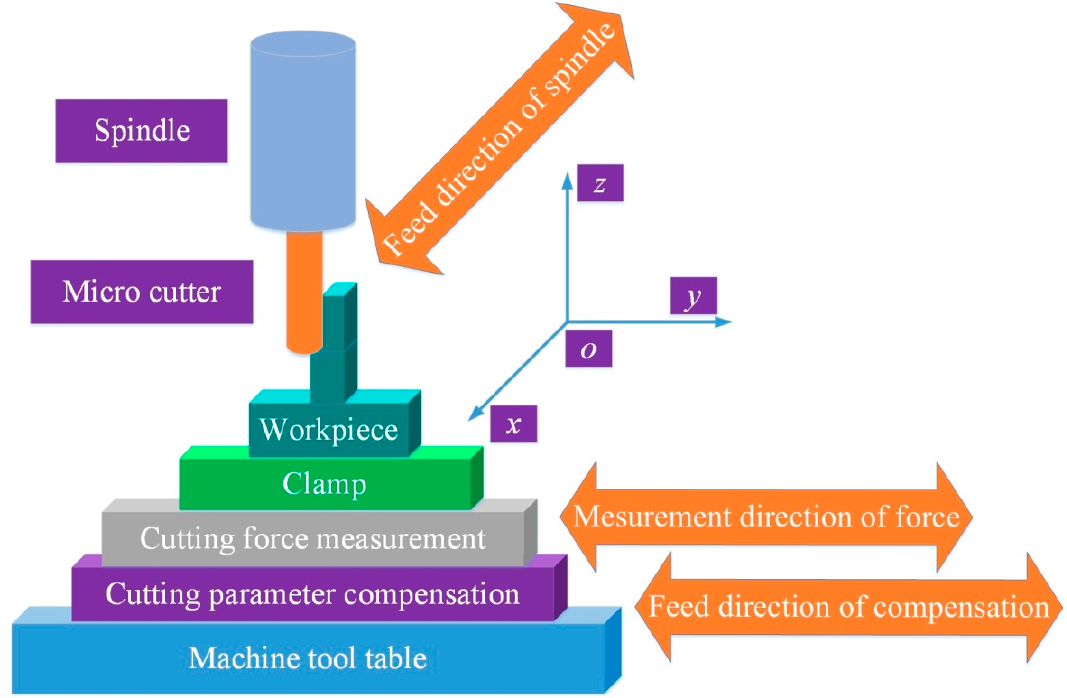
Figure 4. Working principle diagram of cutting force measurement and cutting parameter compensation device.